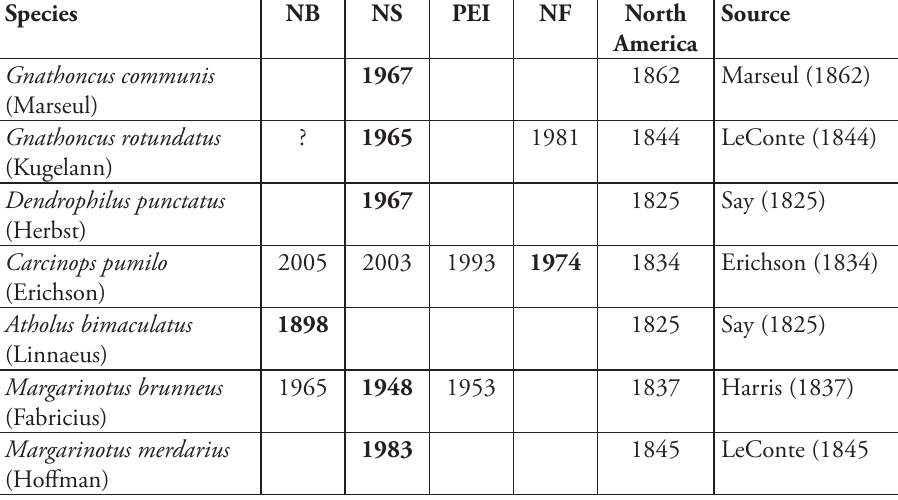
Boldface entries signify the earliest dates for a species in the